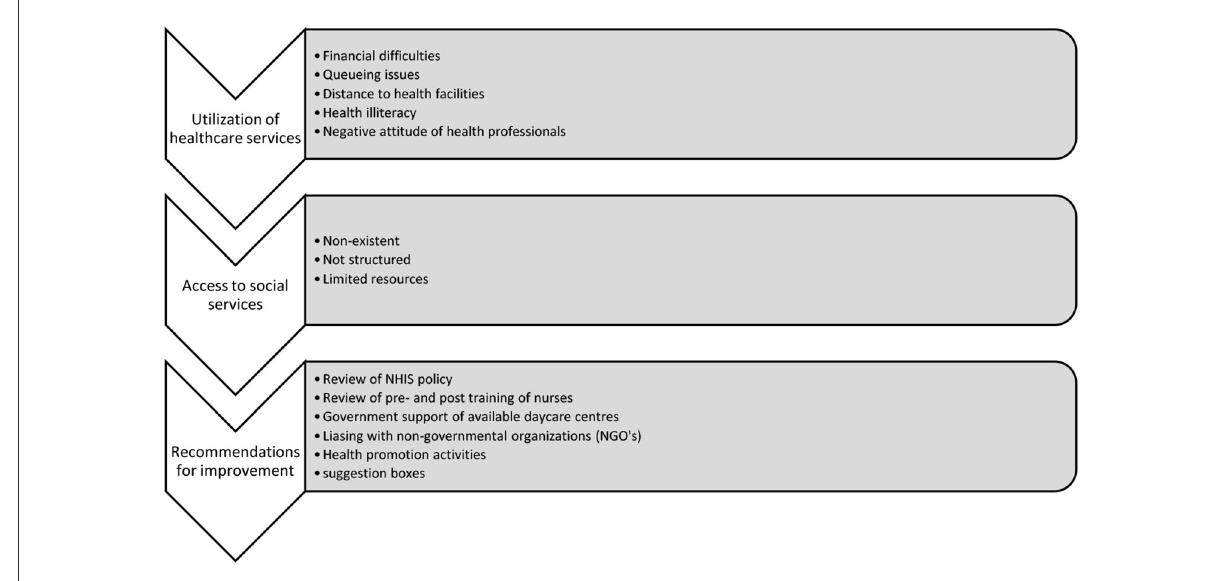
FIGURE1 Chart showing themes and subthemes.